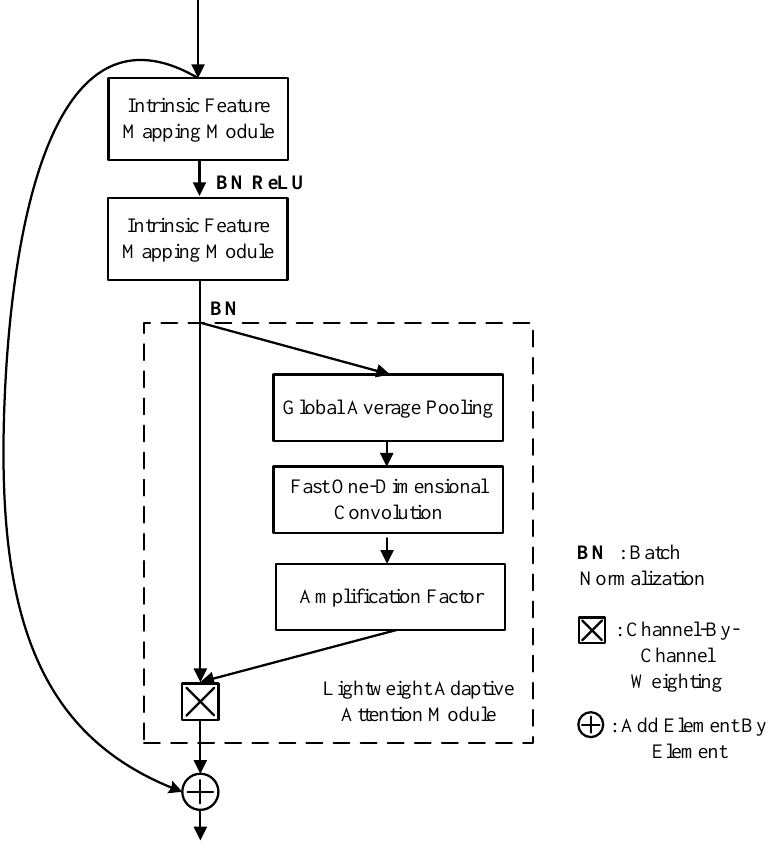
Figure 2. Detail map of L3 layer in lightweight feature attention